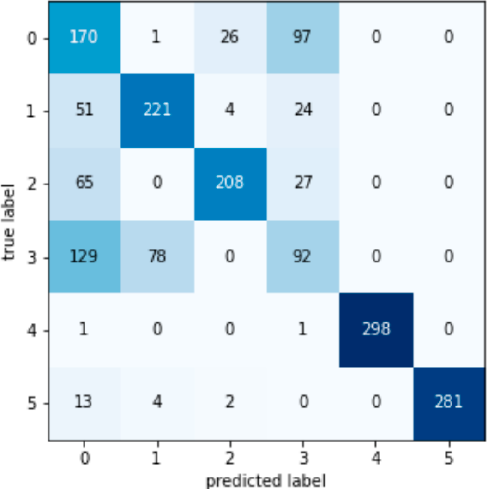
Figure A2. Linear SVM confusion matrix.